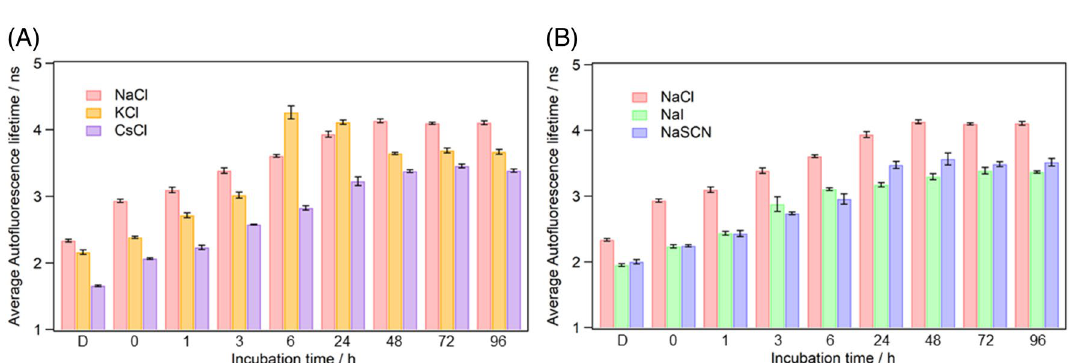
Figure 7. ( A ) Average autofluorescence lifetimes and ( B ) peak wavelengths of the autofluorescence spectra of Q28 and Q64 in the dispersed solution and droplets at various incubation times. Values below the bars are incubation times in hours. “D” below the bar indicates the dispersed solution. The results of Q28 were the same as those in Figs. 2B and 3B. Error bars are SD (The numbers of replicates are summarized in Table S1).